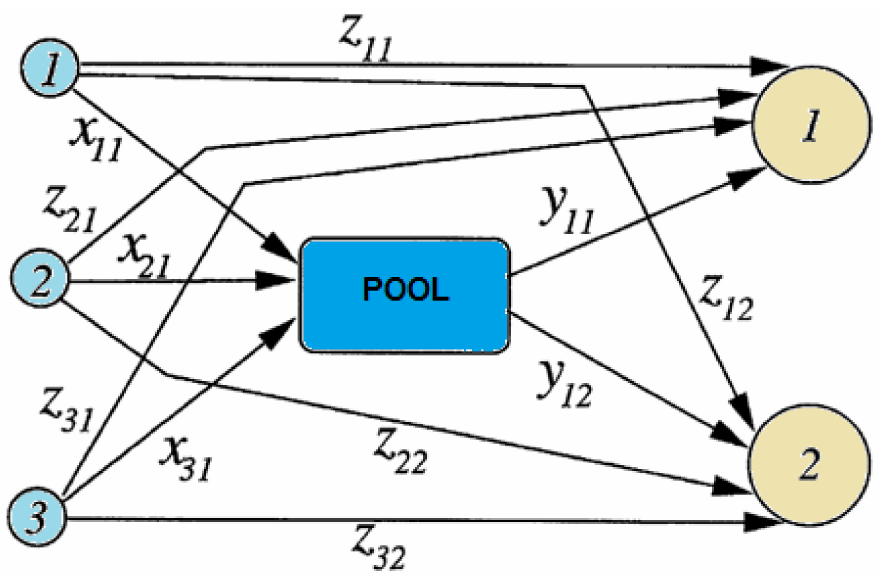
Figure 5. Structure representation of four ingredients polling system pooling